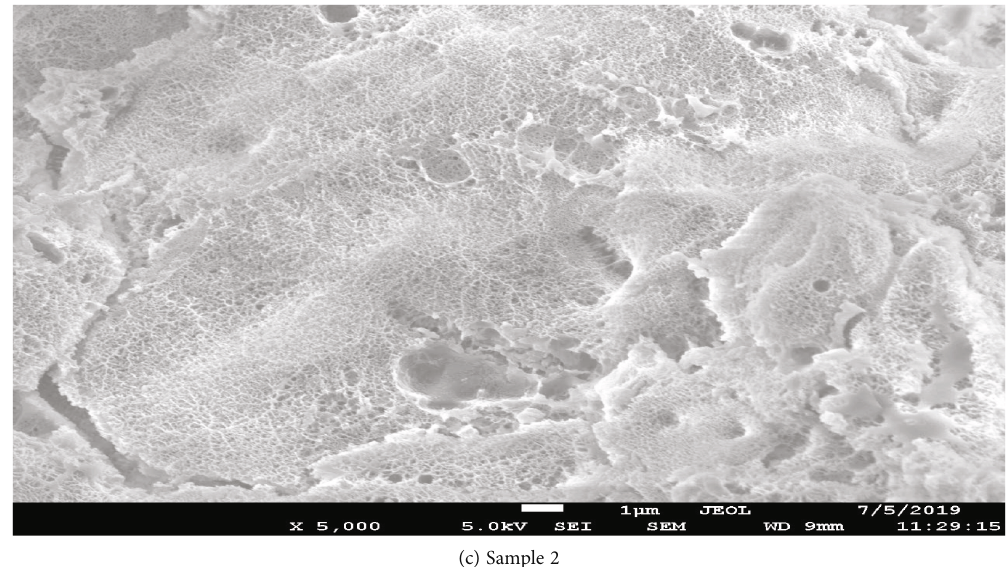
Figure 6: Photo study experienced crumb samples prepared using scanning electron microscopy (total magni fi cation of × 5,000). Grain matrix: (a) control, (b) with the addition of crushed dry turmeric root, and (c) with the addition of nanoemulsions based on curcuminoids